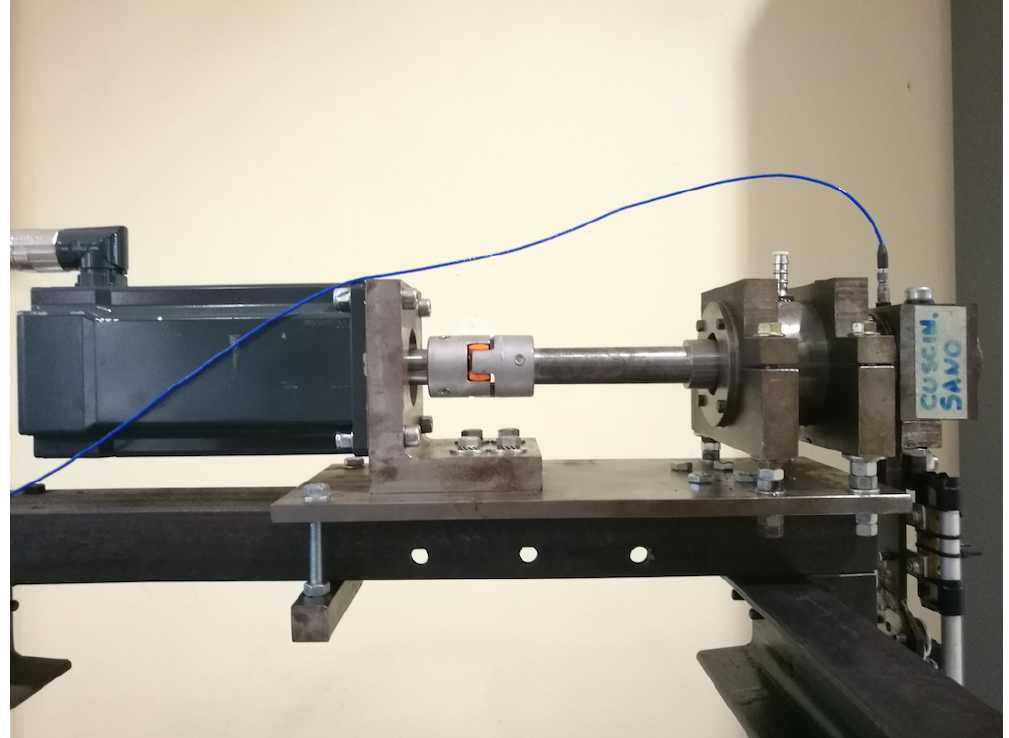
Figure 1. Test rig. From left to the right: the electric motor, the elastic coupling, the main shaft, its support, and the custom case with the bearing under test. The loading system is in the lower part of the custom case, the mono-axial accelerometer is in the higher part.